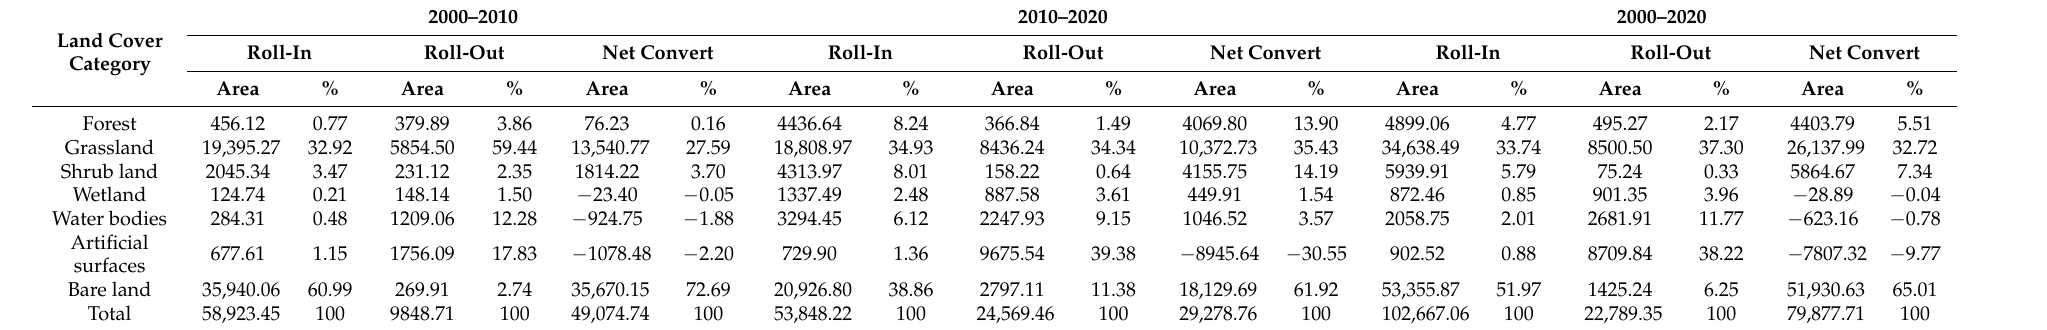
Table 5. The conversion between cultivated land and other land cover categories (hm 2